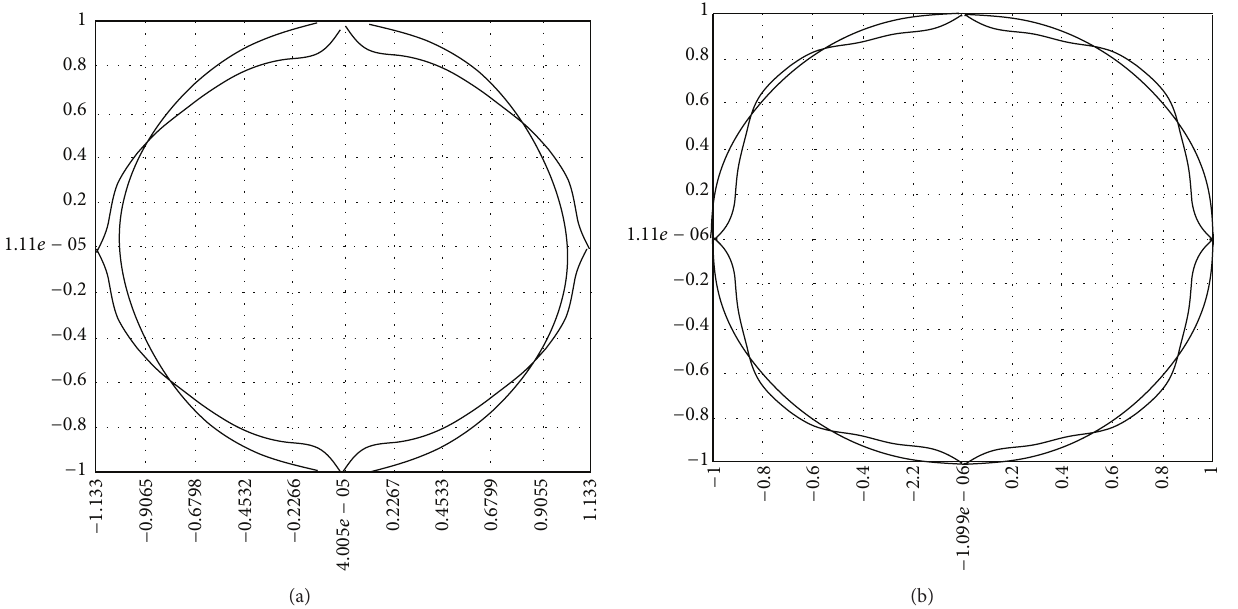
Figure 4: Approximation of vector-function g (𝑡) = ( cos 𝑡, sin 𝑡) by fractal interpolation function g ⋆ with three (a) and five (b) points of interpolation correspondingly.